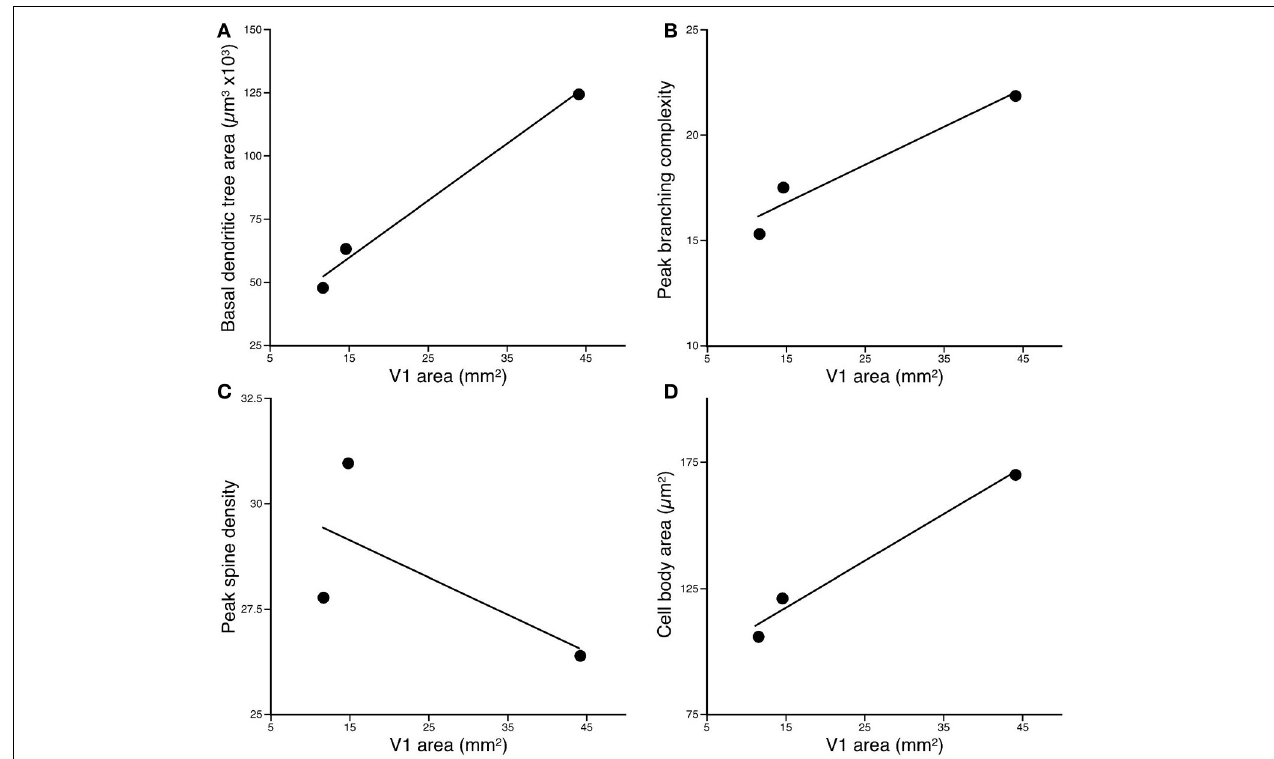
FIGURE 3 | Plots of (A) the size, (B) peak branching complexity, and (C) peak spine density, vs. the size of V1 of the basal dendritic trees of layer III pyramidal neurons sampled in the primary visual area of the Cane Rat, Bushvelt Gerbil, and Striped Mouse. (D) Plots of cell body size of layer III pyramidal neurons vs. the size of V1. The size of the dendritic trees (in the tangential plane) was determined by calculating the area contained within a convex hull, which joined the outermost distal dendrites. The branching complexity was determined by counting the number of intersections of the basal dendrites with a series of concentric circles of